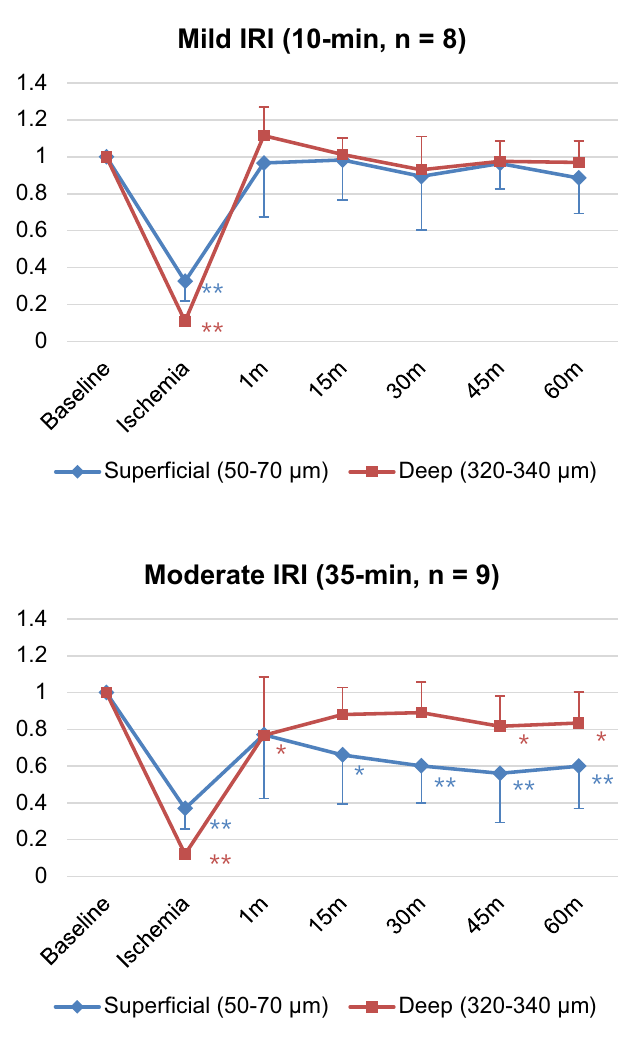
Figure 4. OCTA flow index with respect to the baseline in the mild and moderate IRI groups. * p < 0.05, ** p < 0.01 vs. baseline. The flow indices were analyzed using a nonparametric Mann–Whitney